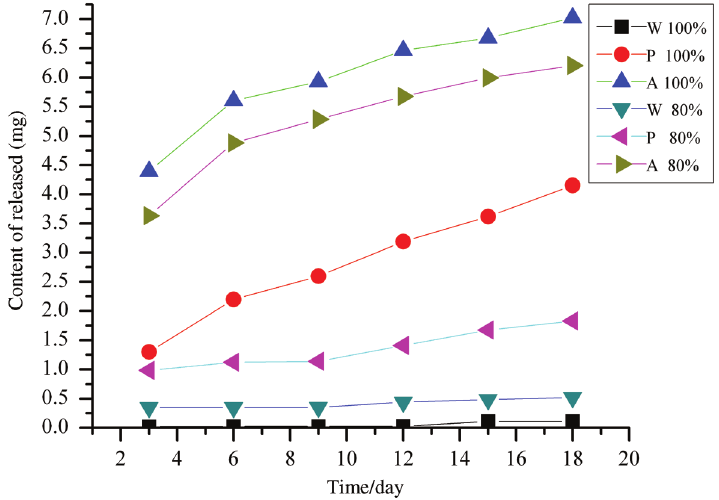
Figure 3 The amount of slow-release in different experimental conditions.